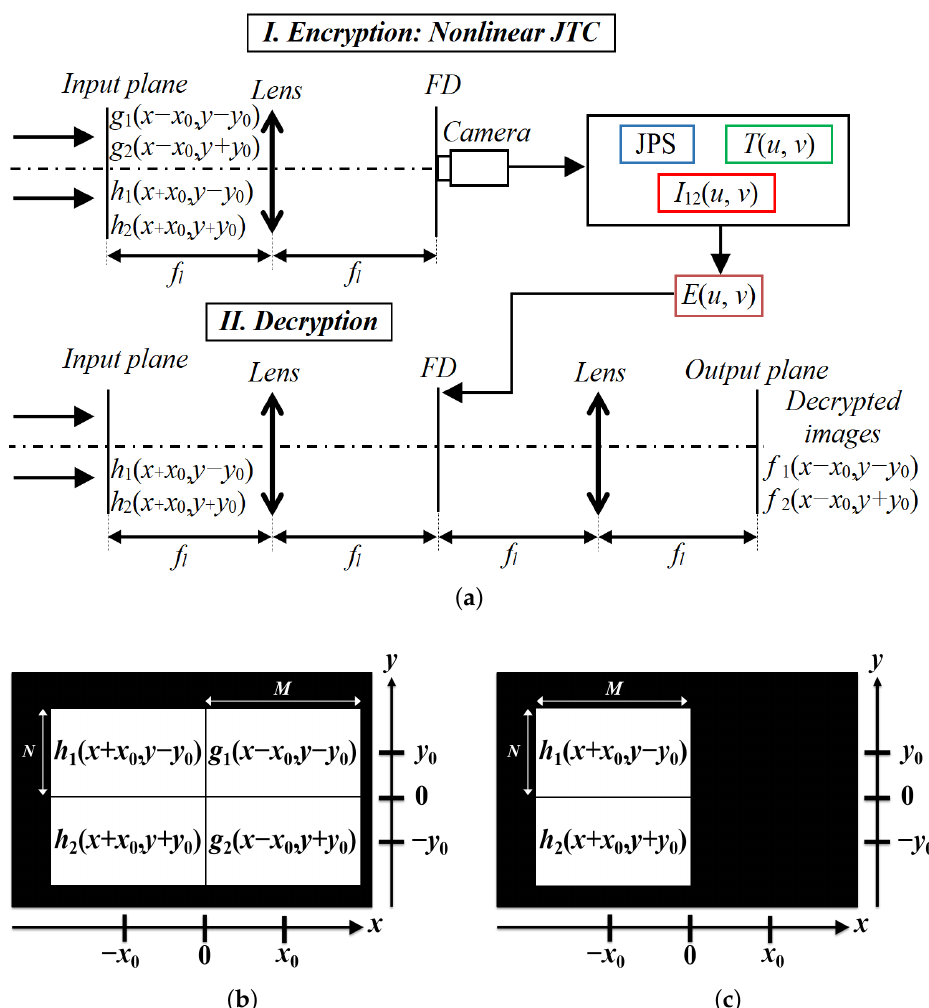
Figure 1. ( a ) The two-image encryption system scheme using a nonlinear JTC architecture (part I) and the decryption system scheme composed of a 4 f -processor (part II). Data distributions located in the input plane of the: ( b ) encryption system, and ( c ) decryption